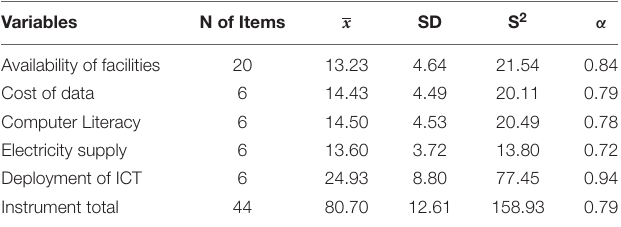
TABLE 1 | Cronbach reliability estimates of the instrument that will be used for data